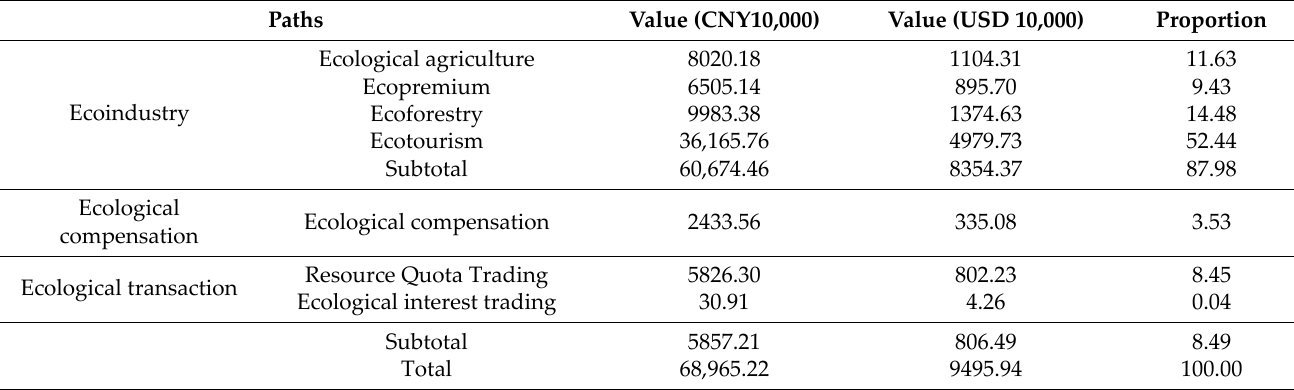
Table 5. Value of ecological products